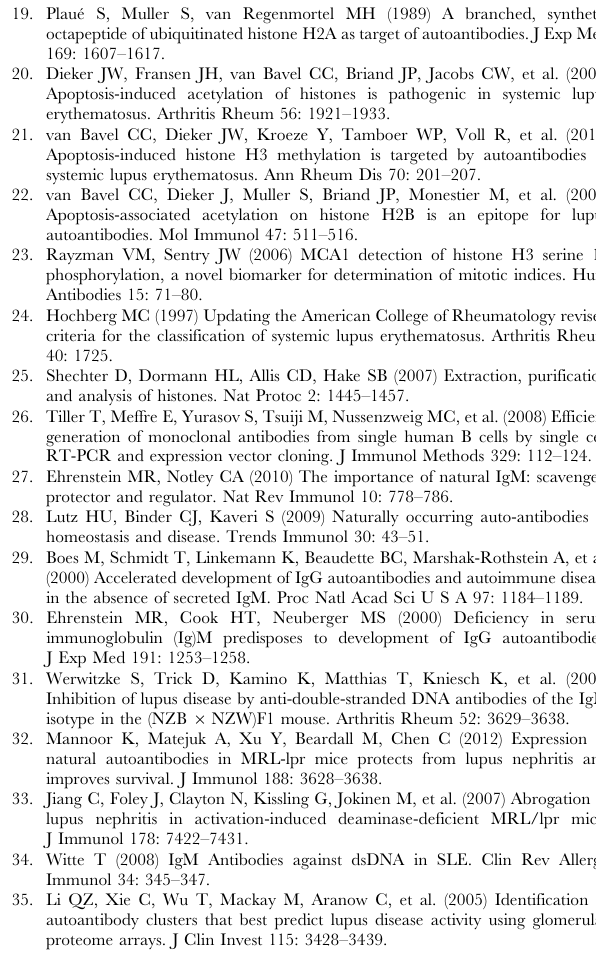
Figure S1 SDS-PAGE of H3 peptides cross-linked to BSA. Synthetic peptide was cross-linked onto BSA. 2 m g (according to the BSA concentration) of each peptide/BSA run on 10% SDS-PAGE under reducing conditions. Figure S2 Serum reactivity to H3 1–19 K9me and GGKme. Microtiter plates were coated with H3 1–19 K9me and GGKme conjugated to BSA. Serum samples (n= 25) from the healthy adults or aSLE patients were diluted 1:100 and tested. KT16 anti- human IgM was used as the primary Ab and HRP-conjugated goat anti-mouse IgG was used as the secondary Ab. Data are expressed as mean 6 SEM. (A) H3 1–19 K9me coated. (B) GGKme coated. The results are shown as representative of two separate experiments. Table S1 Information about the SLE patients and healthy controls. a, M, male; F, female. Ratios were compared